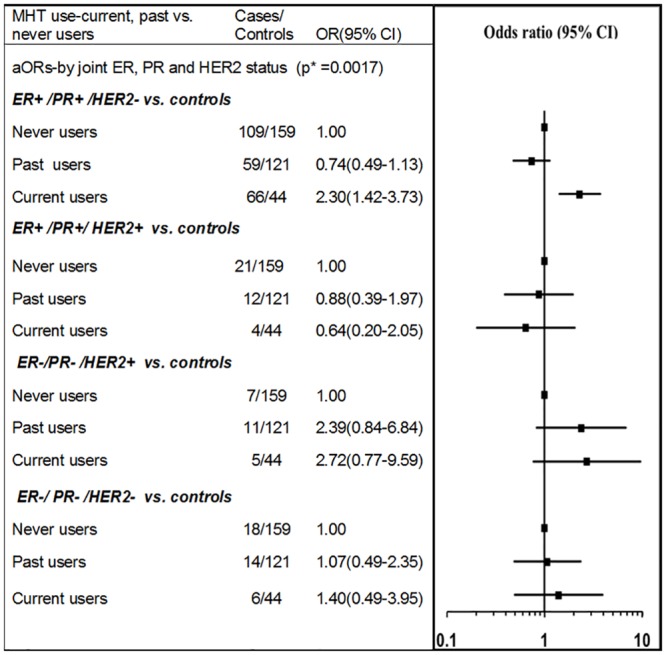
MHT use and invasive breast cancer risk for subtypes based on ER, PR, and HER2 status.P* = p-value is for the test of global null hypothesis that the OR estimates are equal to one (i.e their reference group OR). All odds ratios were adjusted for age at index date, BMI, parity cross-classified by age at first birth, time since menopause, family history of breast cancer, place of residence, socioeconomic disadvantage quintile, oral contraceptive use, breast screening history and alcohol consumption.